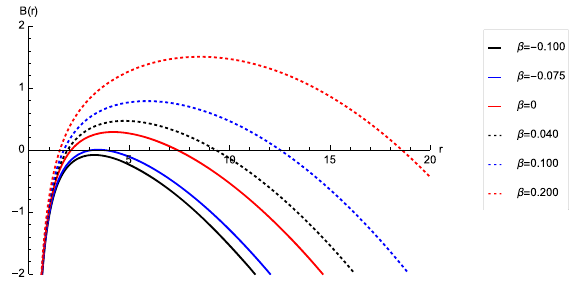
Fig. 1 The behavior of B ( r ) as a function of r for different values of the parameters β with M = 1 and (cid:6) = 0 .